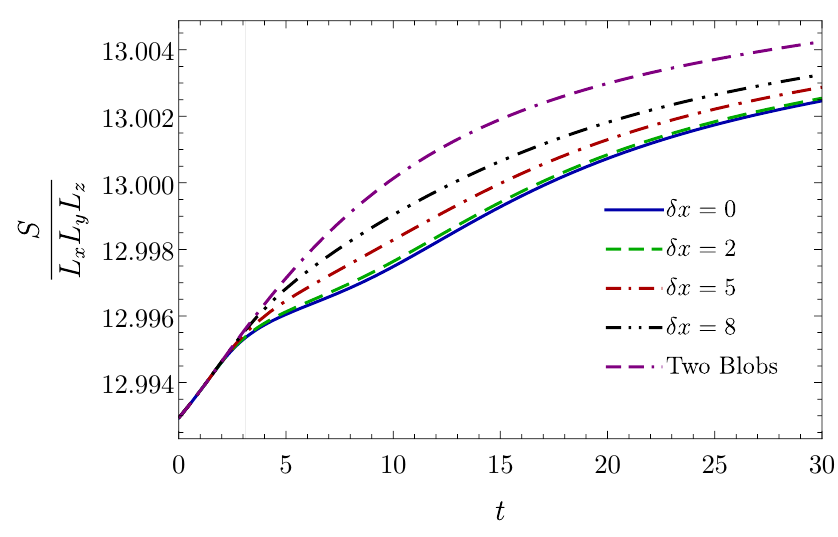
Figure 10 . Average entropy density as a function of time for charged oblate blob collision with several different impact parameters δx . The vertical gray line indicates the collision time, t As a reference, the entropy for the motion of two non-colliding charged oblate blobs is